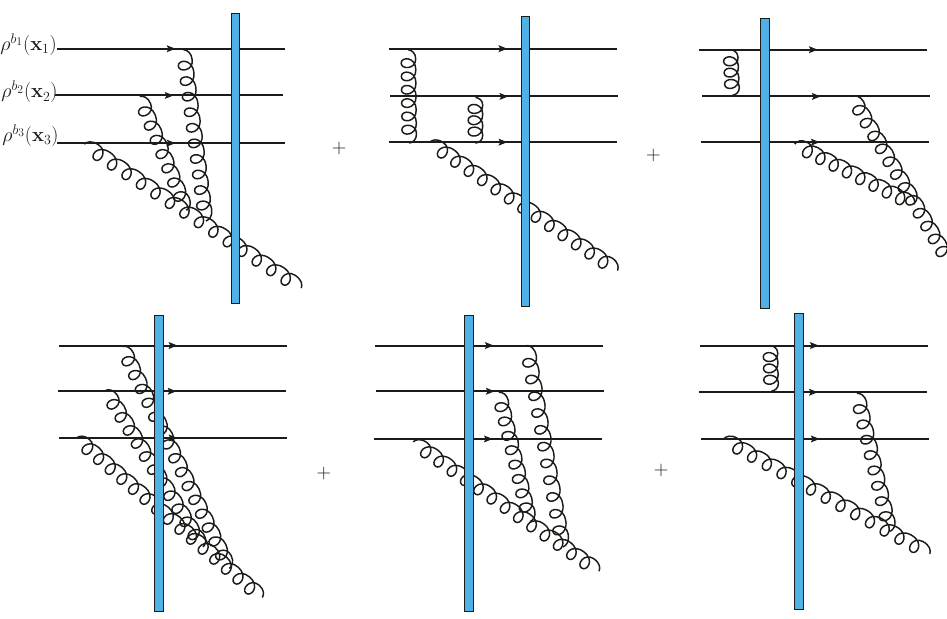
Figure 3 . Partial diagrams showing the order- g 5 single gluon production amplitude. It involves interactions of three color charge densities ρ b 1 ( x